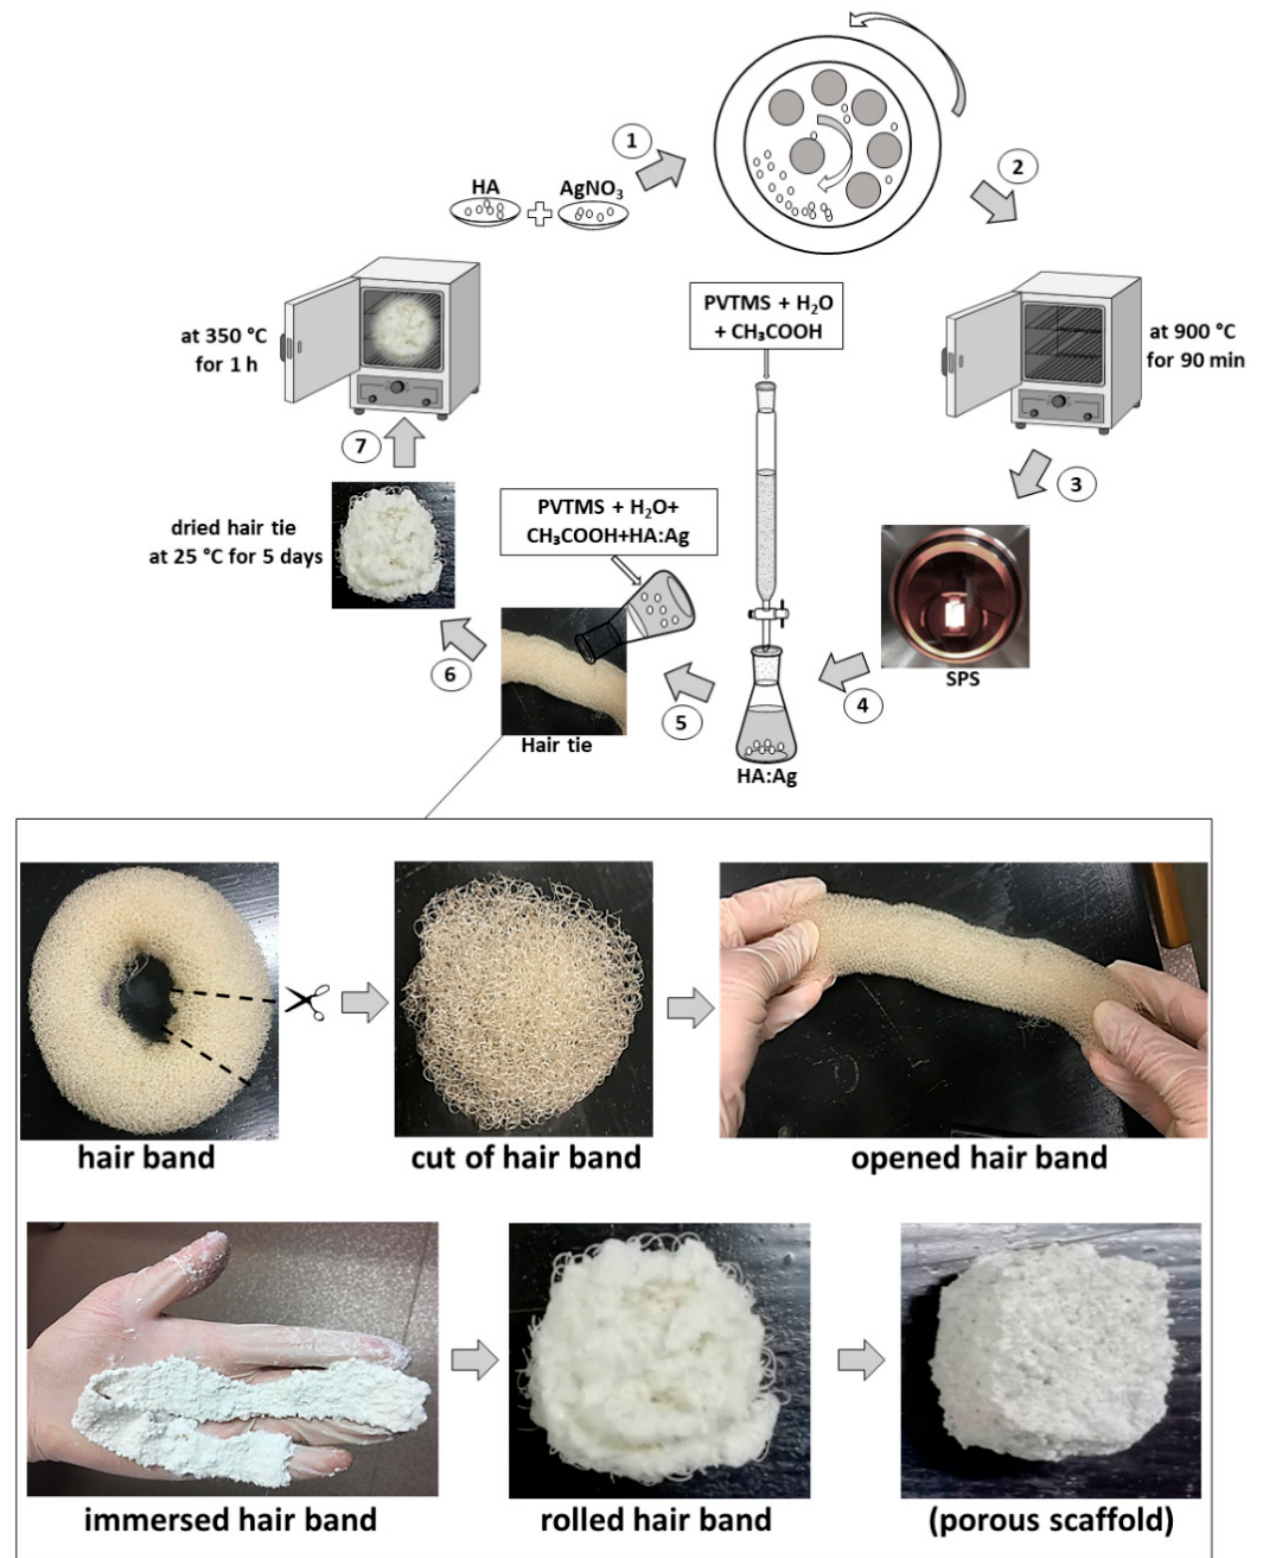
Figure 4. The routes of fabricated Ag-doped HA+PVTMS scaffold.